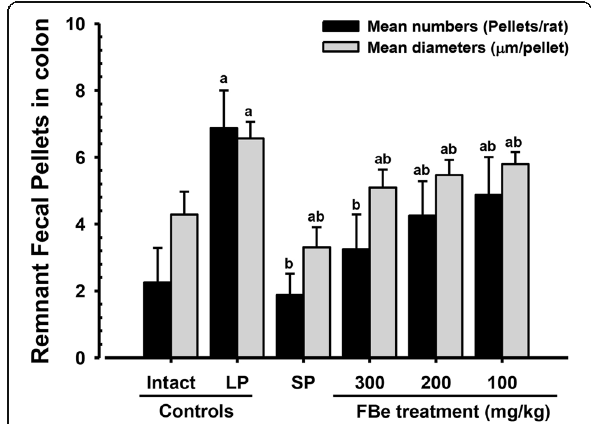
Fig. 3 Fecal pellets remnant in the lumen of colon of the constipation rats induced by LP. Values are expressed mean ± SD of eight rats. FBe: Triple fermented barley extracts, test material; SP: Sodium picosulfate; LP: Loperamide. a p < 0.01 as compared with intact control by LSD test. b p < 0.01 as compared with LP control